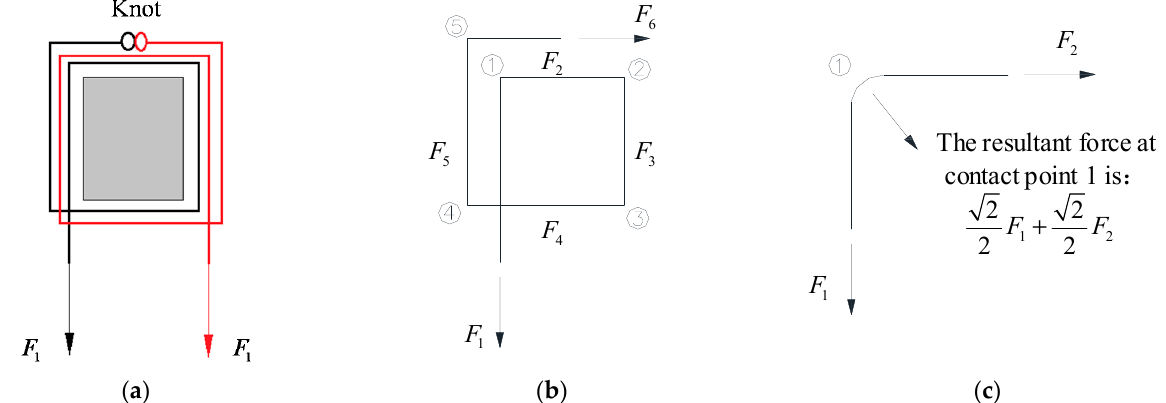
Figure 7. Force analysis of CFR winding segment: ( a ) Schematic diagram of winding segment at the column stub; ( b ) Force decomposition of CFR; ( c ) Force decomposition of CFR at contact point 1.